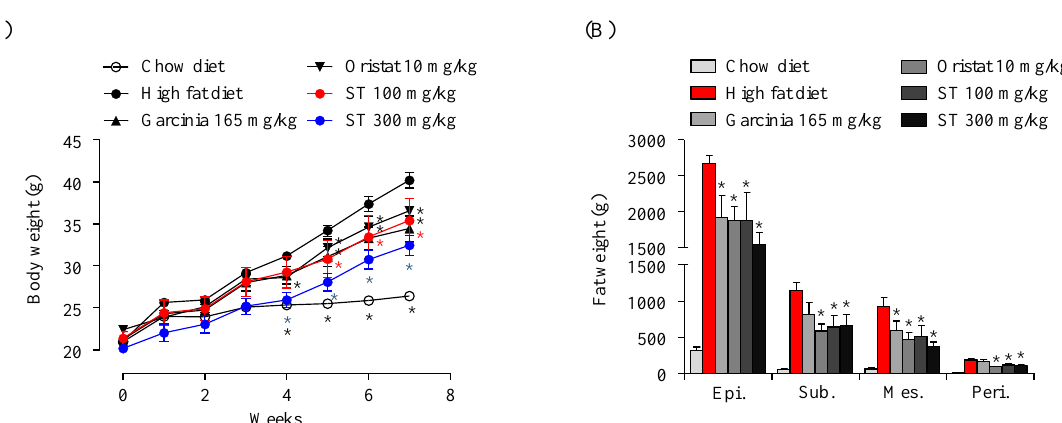
Figure 1. E ff ects of Sargassum thunbergii on body weight and fat accumulation. ( A ) Mouse body weight gain over seven weeks. ( B ) Weight of di ff erent types of fats. Epi: epididymal fat; Sub: subcutaneous fat; Mes: mesenteric fat; Peri: perirenal fat. All data is expressed as mean ± SD ( n = 5 / group). Significant di ff erences were identified at * p < 0.05, as compared to the HFD group. ST: Sargassum thunbergia ethanol extract.